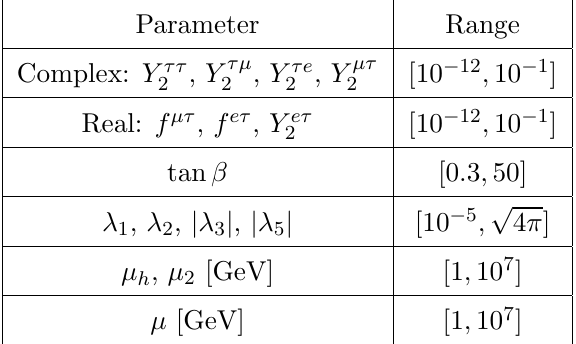
Table 2. Priors on the 19 free real parameters used in the scan. For Y (cid:28)(cid:28) we scan real and imaginary parts independently, while f (cid:22)(cid:28) , f e(cid:28) , and Y e(cid:28) real without loss of generality. We use logarithmic priors for all parameters except for tan (cid:12) , where uniform priors are